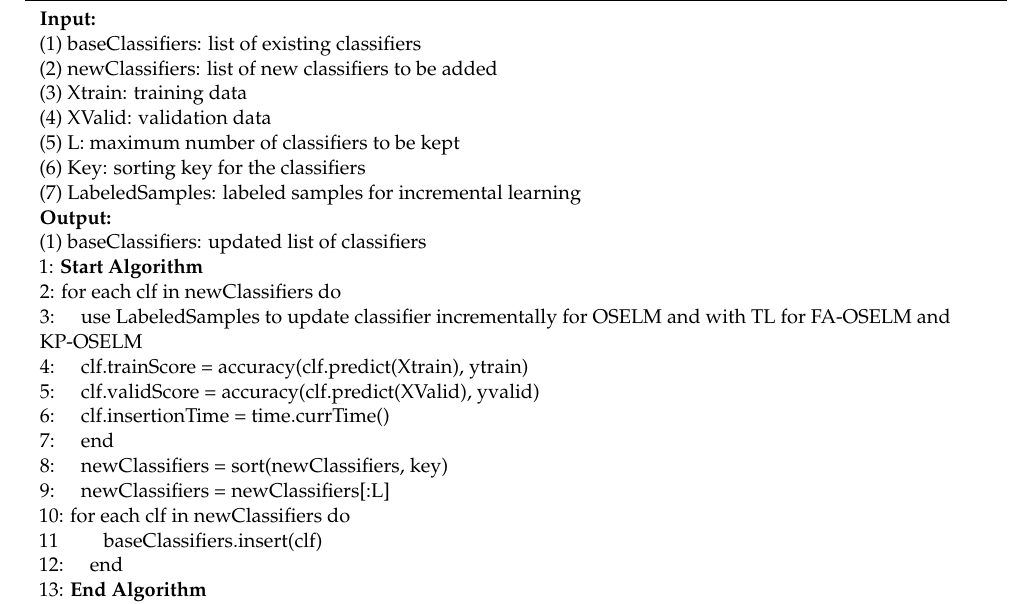
Algorithm 6. Pseudocode of classifier update for the incremental GPC.